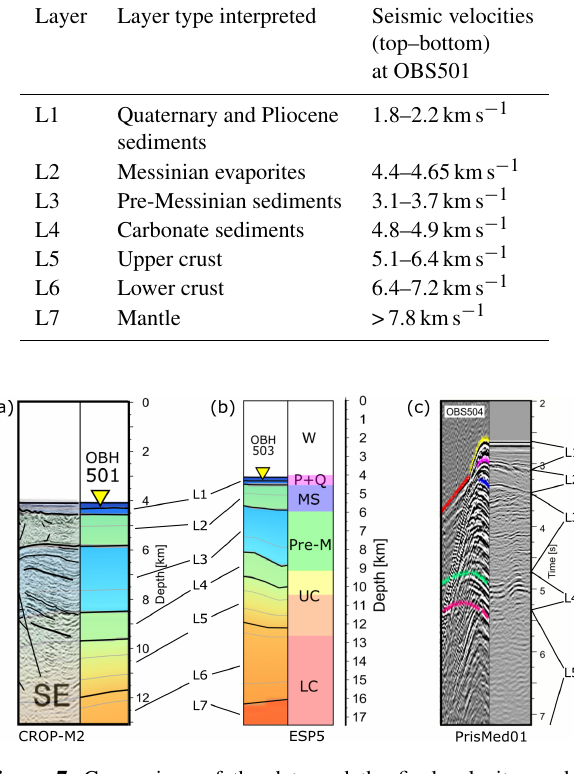
Figure 7. Comparison of the data and the final velocity model from this study (OBH501, OBH503, OBS504) with previous stud- ies: (a) CROP M2 (Polonia et al., 2011), (b) ESP5 (de Voogd et al. 1992), and (c) PrisMed01 (Gallais et al., 2011). L1–L7 follow the same layer convention as in the final velocity model.